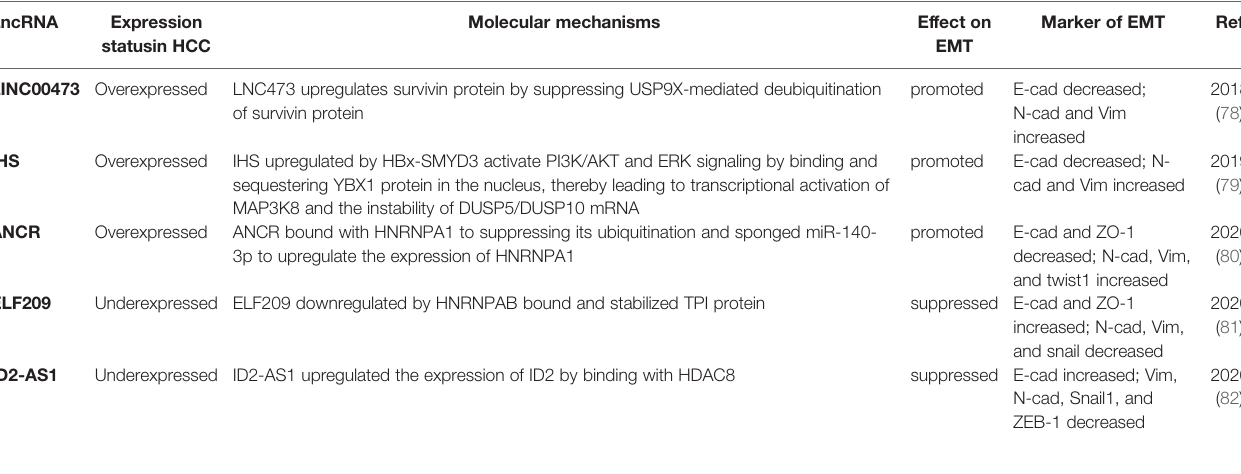
TABLE 2 | LncRNAs regulate EMT via other special signaling